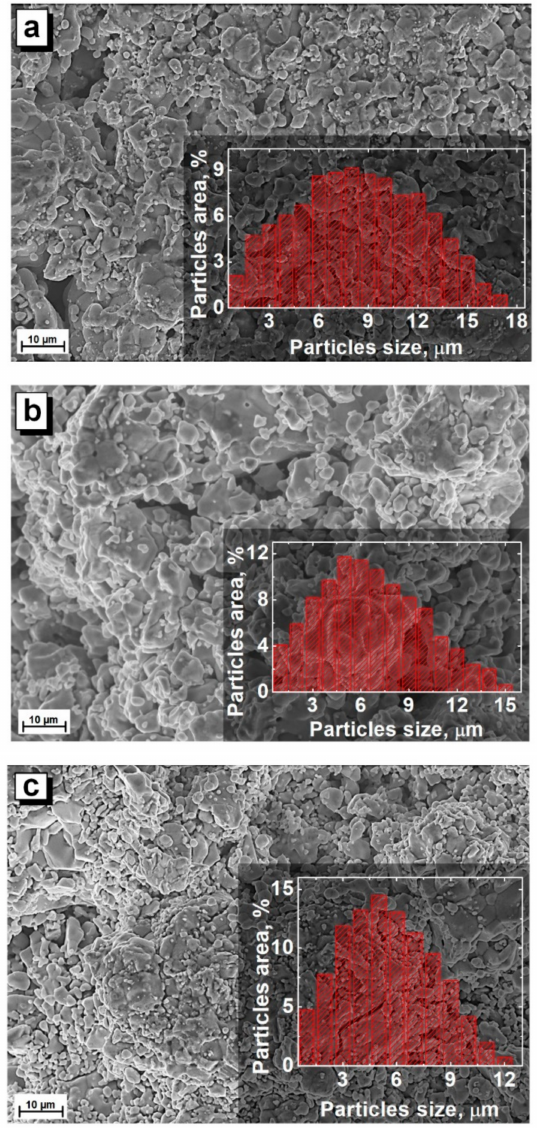
Figure 3. SEM image for the Sm- ( a ), Eu- ( b ), and Gd-based ( c ) samples. Inset demonstrates the particle size